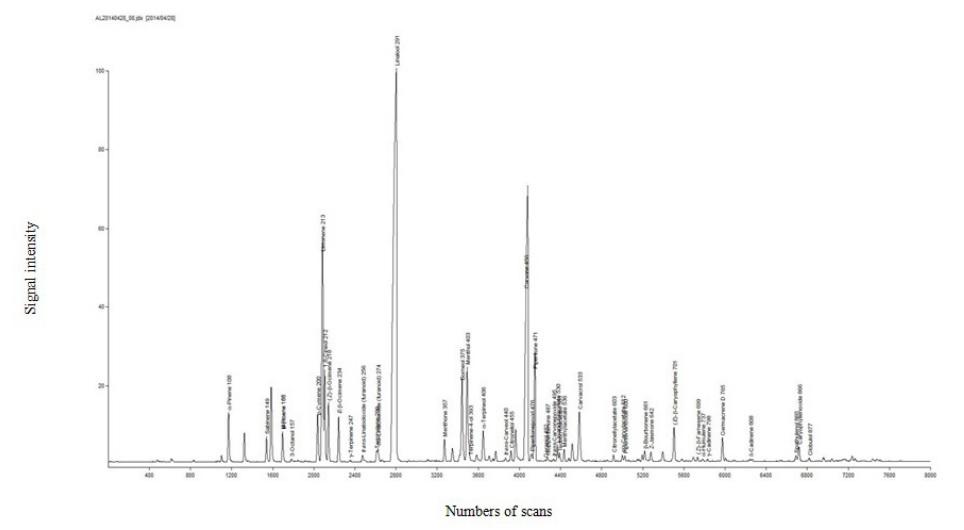
Figure 2: GC-MS chromatogram of M. spicata var. Crispa essential